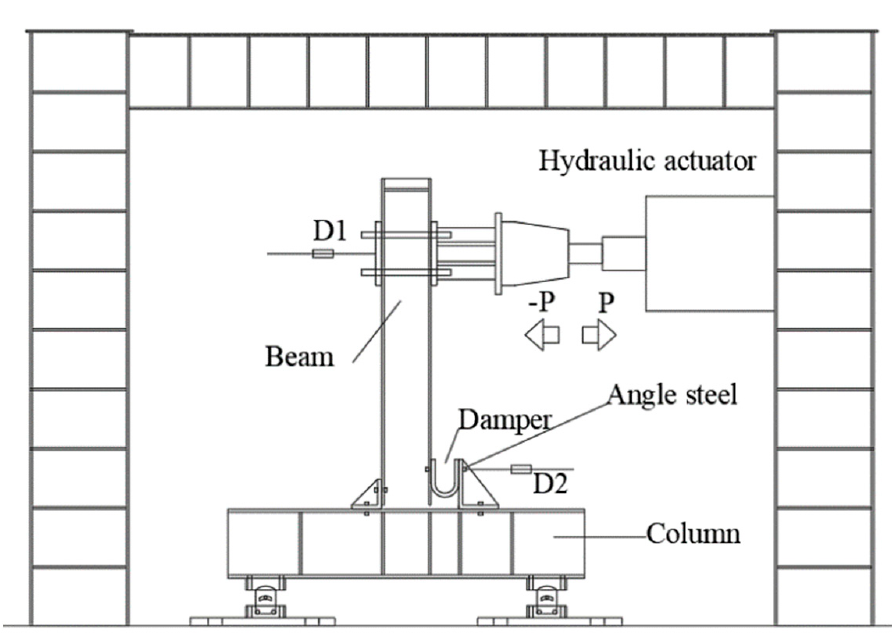
Figure 5. Position of the displacement meter.